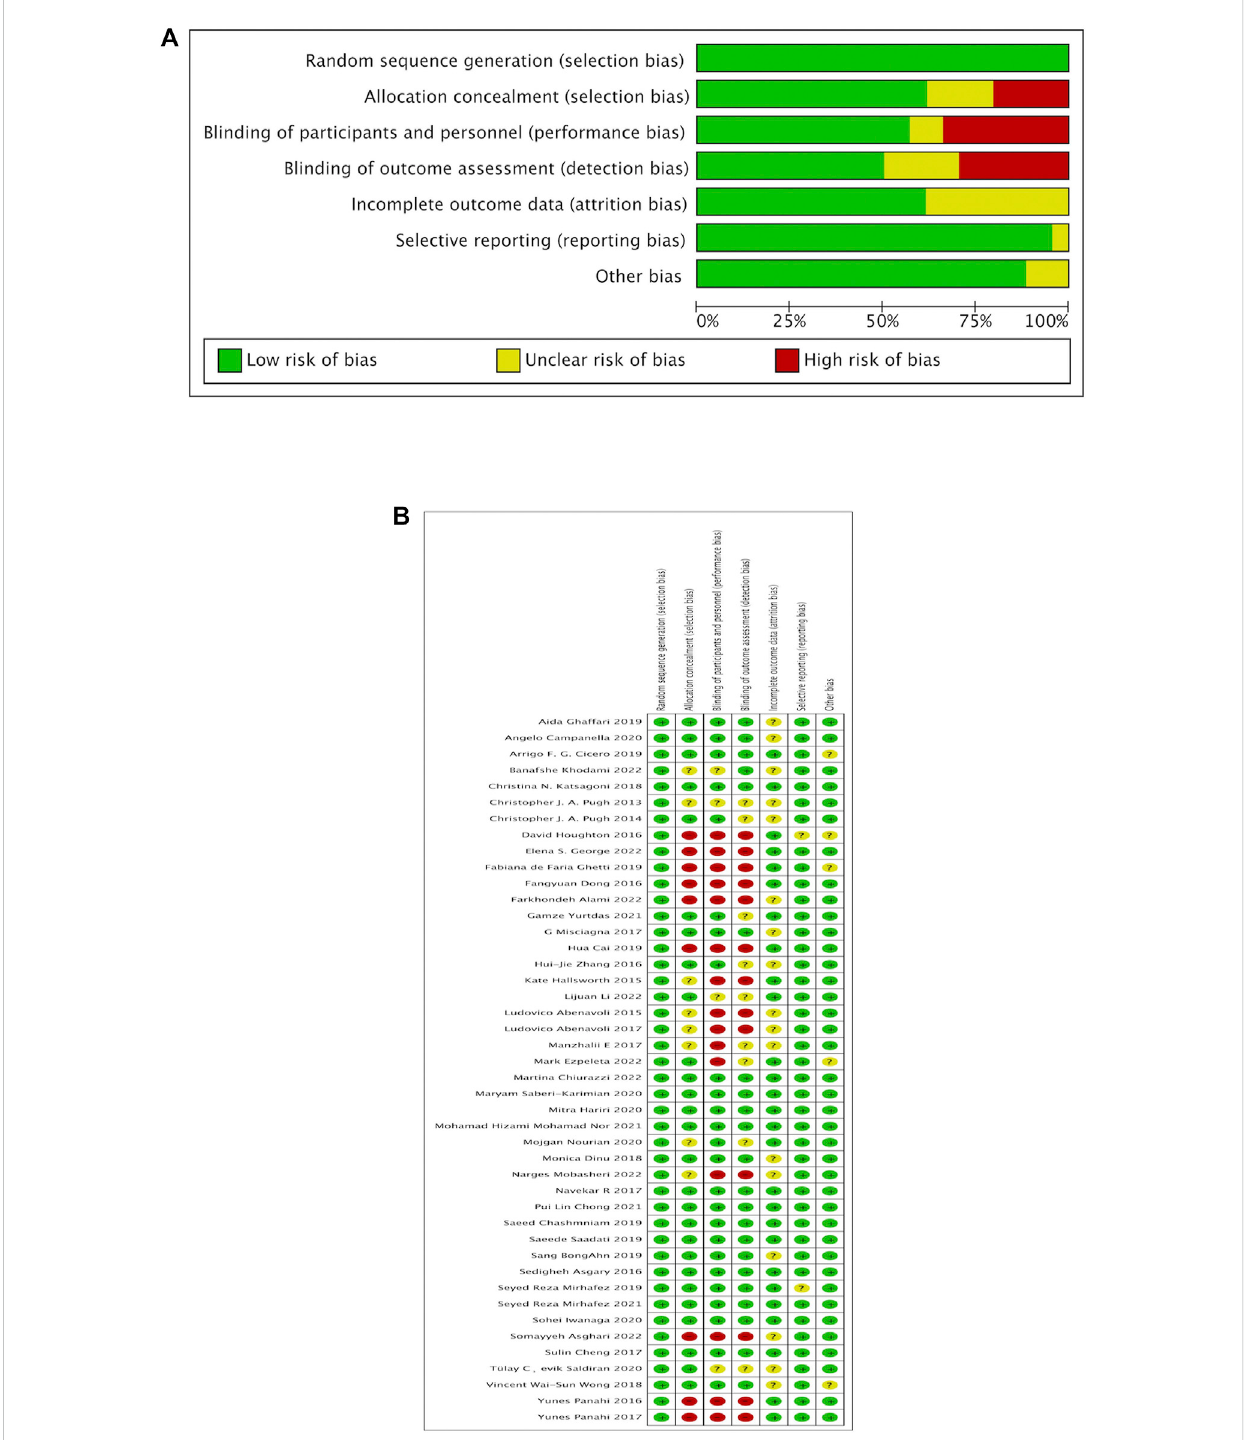
FIGURE 2 Quality assessment (Cochrane risk of bias tool) for included RCTs. RCT, randomized control study, (A) Risk of bias graph, (B) Risk of bias